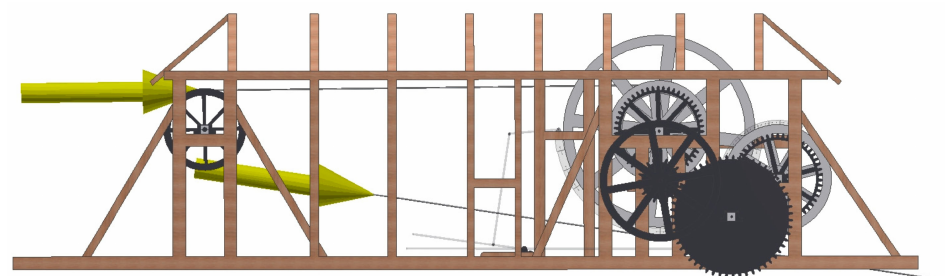
Figure 10. Forces applied on the pulley in the direction of the rope.